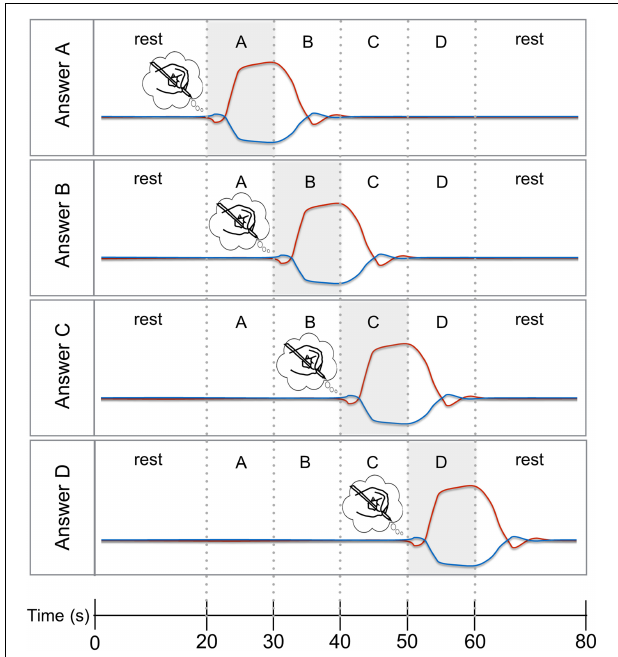
FIGURE 1 | Four-choice temporal encoding paradigm with expected time courses. Hypothesized HbO (red line) and HbR (blue line) responses for the four answer options “A”, “B”, “C”, and “D”. To chose answer option “A” (top panel), the participant had to start mental imagery upon the cue presented 20 s after trial onset and stop the mental imagery when answer option “B” was presented. For the remaining trial time, the participant had to rest and await the subsequent encoding trial. The other three panels show the hypothesized HbO and HbR response for answer options “B”, “C”, and